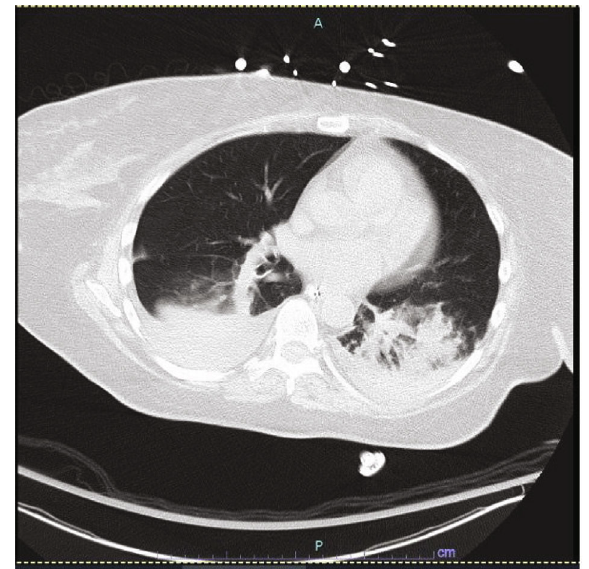
Figure 2: CT chest later in the course of hospitalization demonstrating bilateral basal opacities with pleural e ff usion.